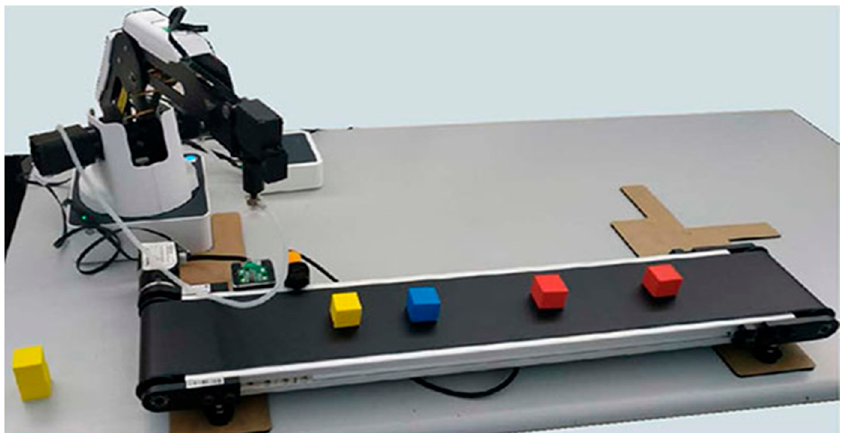
Figure 1. Dobot Magician and its rail in a robotic lab course.